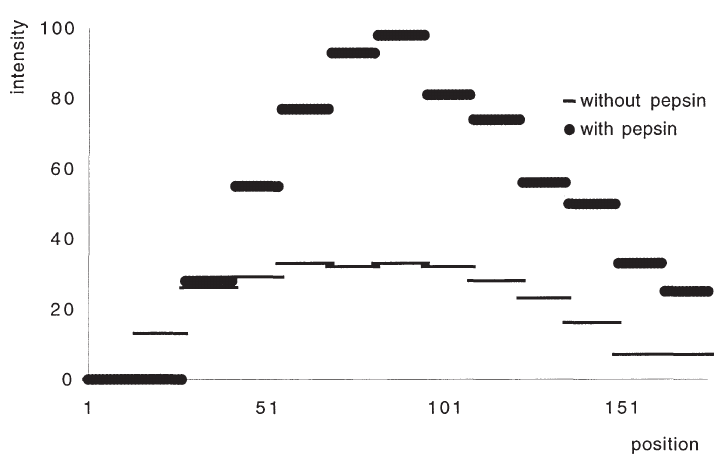
Fig. 3. Effect of pepsin on the fluorescence profile of the FISH spot, example of a FITC detected spot. The fluorescence intensity (in arbitrary units) is expressed as a function of the position on the spot diameter (in arbitrary